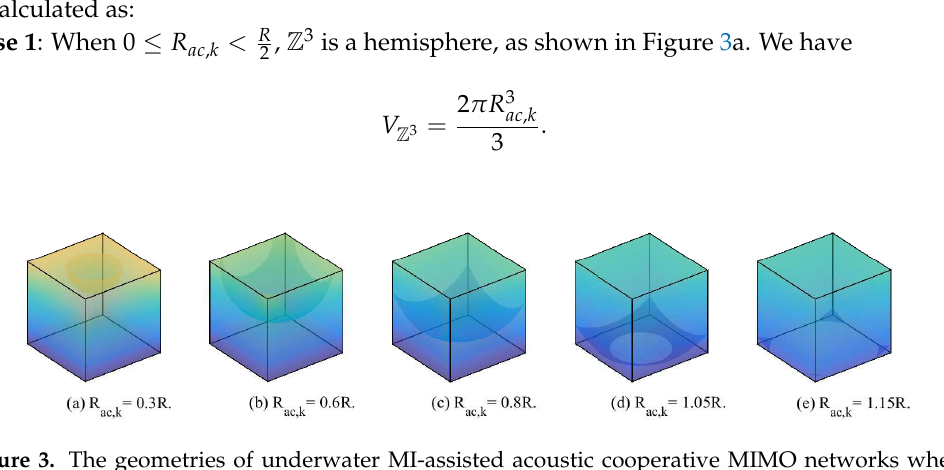
Figure 3. The geometries of underwater MI-assisted acoustic cooperative MIMO networks when directly